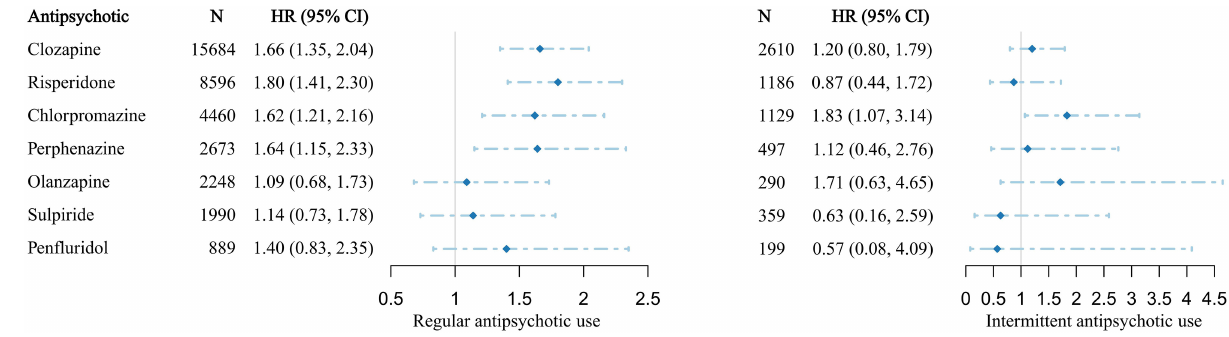
FIGURE 3 | Antipsychotic-related hazard ratios of T2DM in patients with schizophrenia receiving monotherapy. HR, hazard ratio; CI, confidence interval. HRs and 95% CIs were calculated by multivariate-adjusted Cox regression